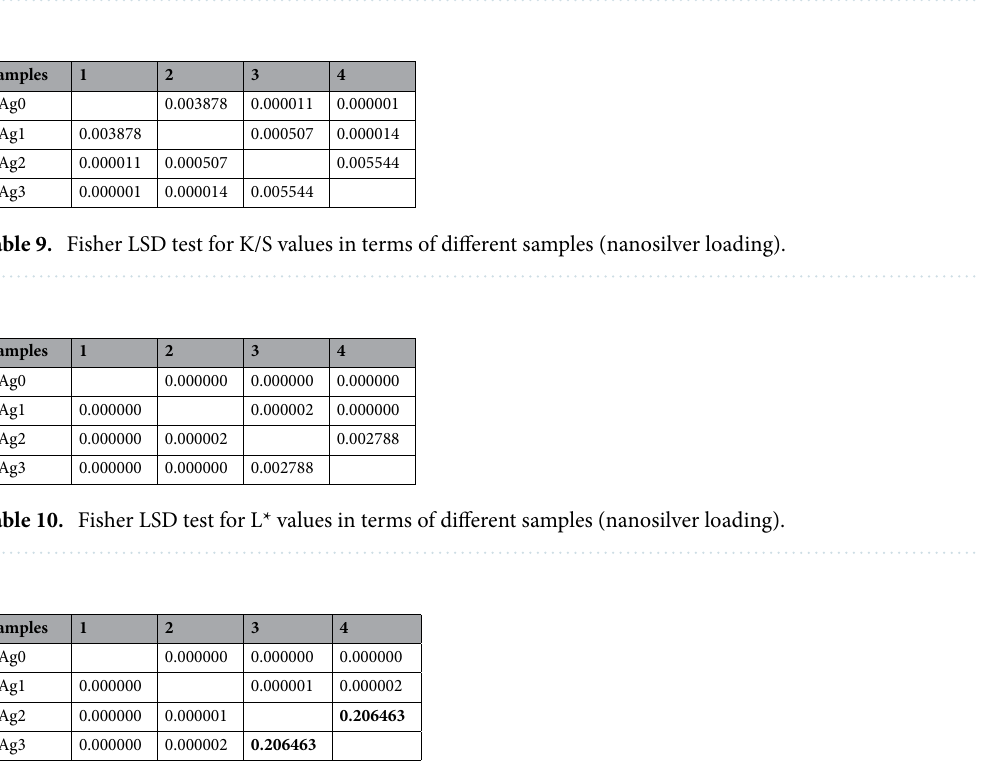
Table 11. Fisher LSD test for a* values in terms of different samples (nanosilver loading). Bold p values indicate not significant.